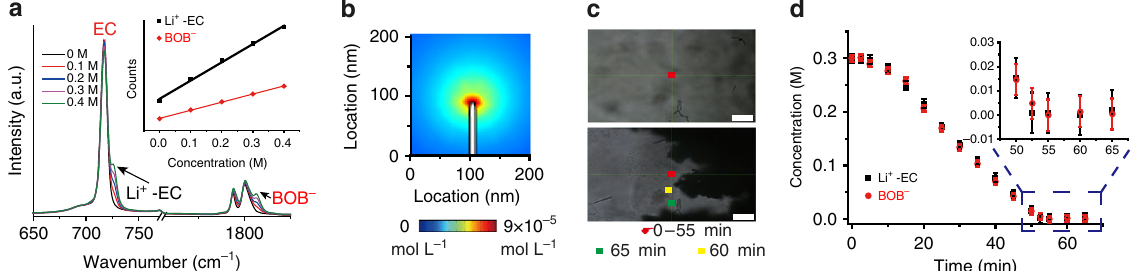
Fig. 2 Experimental and simulation results for validating “ charge neutrality ” . a The spontaneous Raman spectra of LiBOB / (TEGDME: EC v/ 7:3) electrolyte with a concentration from 0 M to 0.4 M. Inset is the plot of counts at the designated wavenumber (725 cm – 1 for Li + -EC solvent solvation and 1830 cm – 1 for BOB – ) versus the concentration of LiBOB. b COMSOL fi nite element simulation on a 10 nm wide electrode tip during lithium reduction to show that the concentration difference between the cation and anion is less than 0.09 mM. A zoomed-out image can be found in Supplementary Fig. 2. c Optical images of the Li electrode at the beginning and end of lithium electrodeposition. The colored squares show positions where the Raman spectra were taken, which is near a lithium dendrite tip. Corresponding Raman spectra and voltage pro fi le can be found in Supplementary Fig. 3. White scale bars are 50 μ m. d The concentration changes in Li + and BOB – vs. time at the locations and times in c . The average difference between [Li + ] and [BOB – ] at 16 points is well below 2 mM at a noise level of 8.3 mM for Li + -EC solvent solvation and 5.8 mM for BOB ion – solvent interactions in electrolytes, such as solvent-separated instrument noise level (~ 8 mM), further con fi rming the validity ion pair (SSIP), contact ion pair (CIP) or aggregate (AGG), will of using [BOB – ] to derive the local [Li + ] at the given resolution not affect the study as the Raman intensity is still linearly related (10 mM and 500 nm, Supplementary Note 2, Supplementary to the ion concentration (Supplementary Note 3, Supplementary Fig. 3). In addition to obeying “ electroneutrality ” , ion – ion and